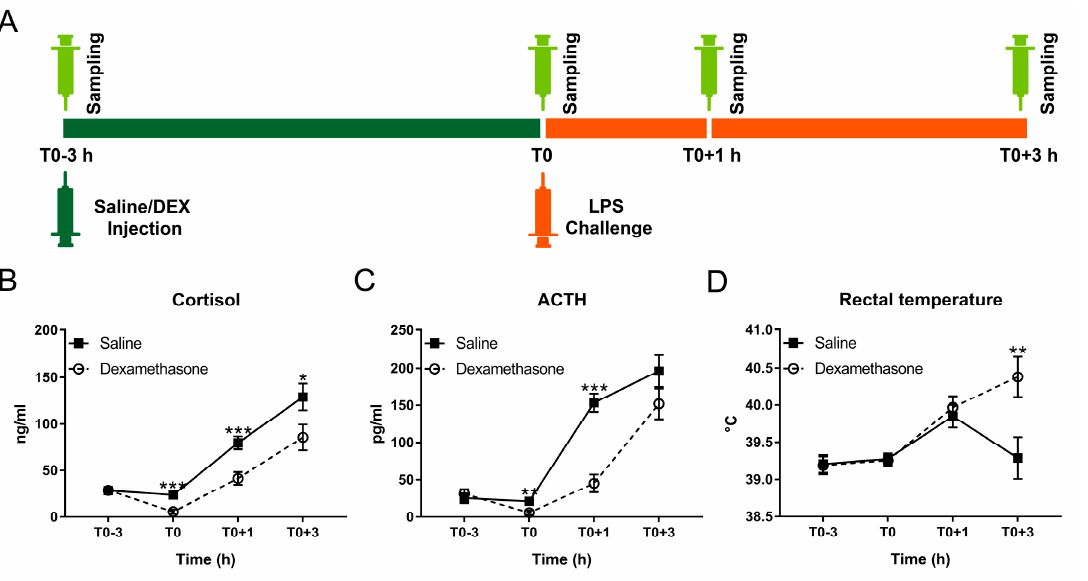
Figure 1. Effect of dexamethasone (DEX) on febrile and neuroendocrine responses following lipopolysaccharide (LPS) challenge. ( A ) Schematic diagram of experimental design; ( B ) cortisol; ( C ) adrenocorticotropic hormone (ACTH); and ( D ) rectal temperature. Data are presented as least-squares means ± SE. * p < 0.05, ** p < 0.01, *** p < 0.001.